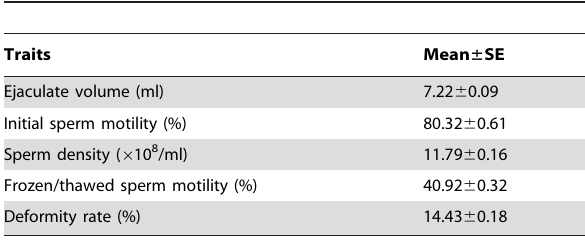
Table 1. Mean and standard error (SE) of sperm quality traits in Chinese Holstein